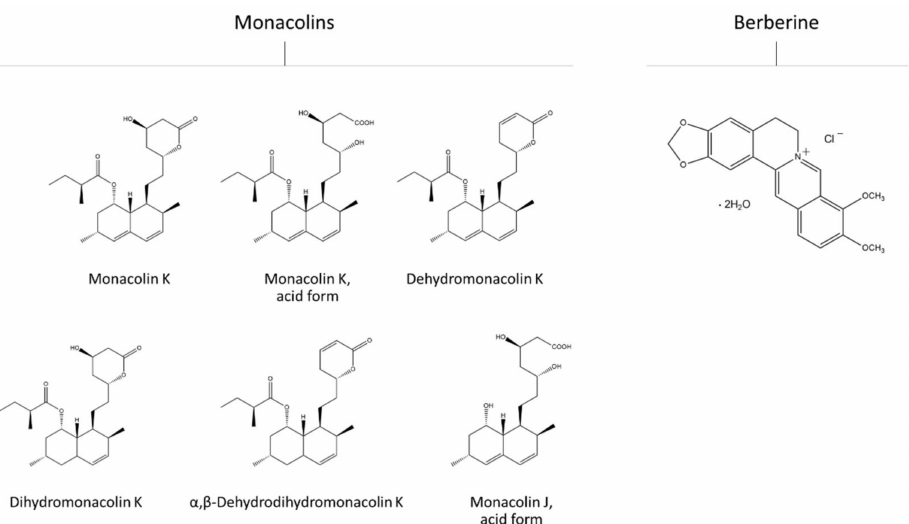
Figure 1. Chemical structures of the compounds evaluated in this study. Monacolins are the main bioactive constituents of dietary supplements containing red yeast rice, while berberine (BBR) is the main active compound of dietary supplements containing B. aristata powders and dried